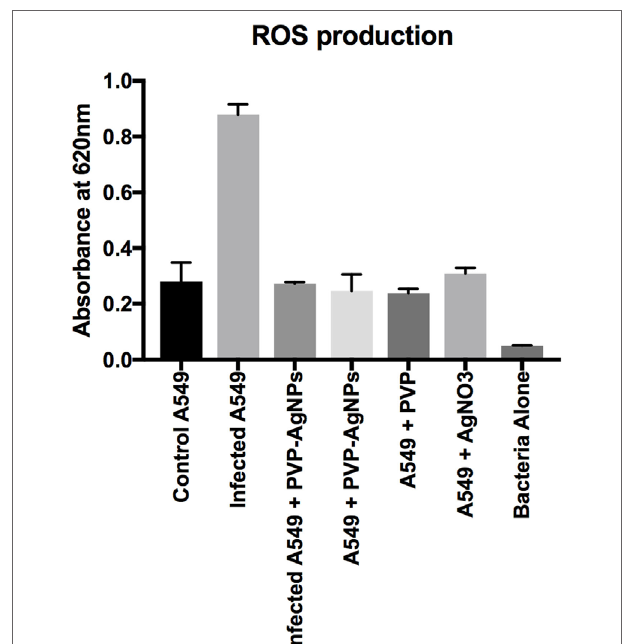
FigUre 6 | Reactive oxygen species (ROS) production by A-549 under different conditions of infection and treatment. ROS production by A-549 under infected condition was calculated by subtracting ROS produced by bacteria alone. Experiment was performed in triplicate and data are presented as mean ± SD.